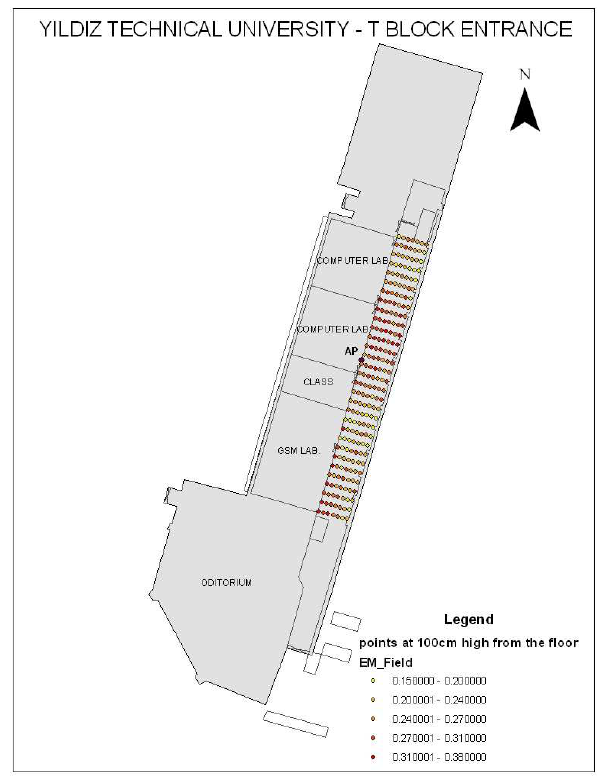
Figure 4. T-Block entrance floor map, access point (AP), observation points and electromagnetic field values (V/m) at 100 cm from the